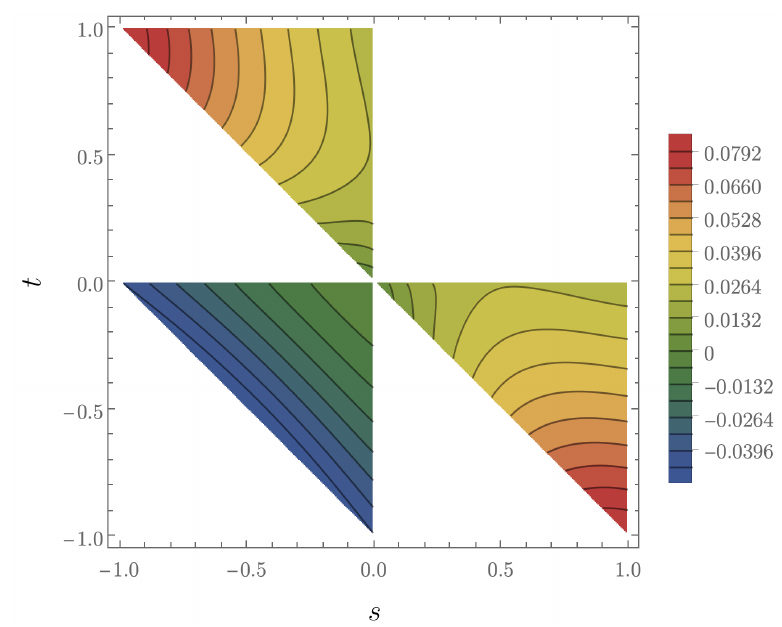
Figure 10: Numerical plot of the planar contributions (3.73) and (3.74) to the type I amplitude as a function of the Mandelstam invariants s and t in the three physical = 1 and normalized by 1 ( s − 1 ) 2 ( t − 1 ) 2 in order to t regions. We have set g 4 8 s 2 9 π 2 remove the double poles at s = 1 and t =